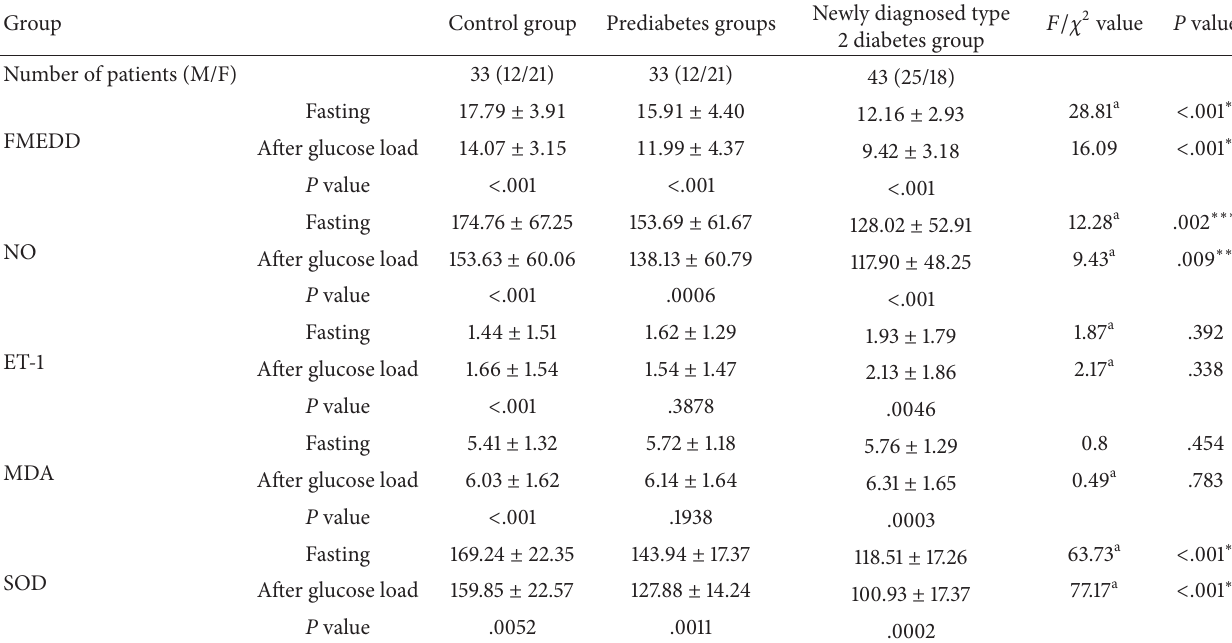
Table 3: Differences between FMEDD, NO, ET-1, MDA, after SOD after glucose load.